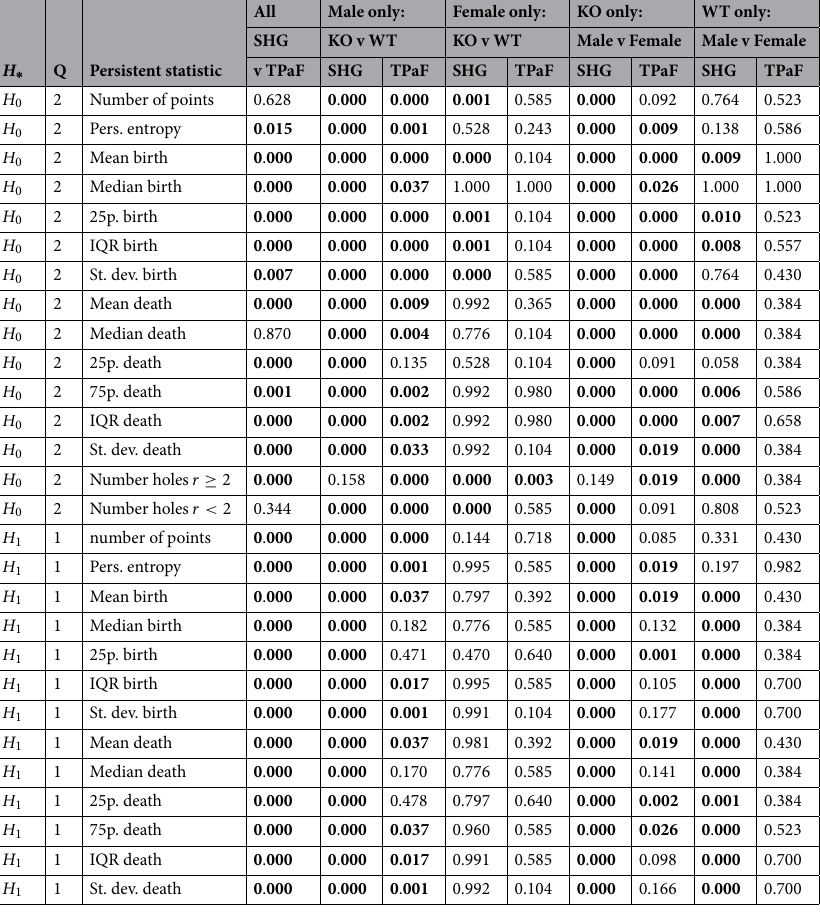
Table 2. Benjamini–Hochberg adjusted pseudo p -values (3 d.p.) from permutation tests for 28 test statistics with paired tests to compare the imaging types and tests between OcnVEGFKO (labelled KO above) and WT males and female groups using either the SHG or TPaF images. To see if there is a significant difference from the imaging technique we paired the TPaF and SHG image patches per statistic. Also, for SHG and TPaF separately we tested the hypothesis that the distributions are the same for males between OcnVEGFKO (test) and WT (WT); females between OcnVEGFKO and WT; OcnVEGFKO between male and female; and WT between male and female. All p -values in bold are significant at the 5% level. The adjustments were made separately for the statistics from TPaF and SHG images in the OcnVEGFKO/WT M/F group comparisons. Here H ∗ is the homology group, Q is the quadrant and we have included statistics from the H 0 quadrant 2 (separate micro-holes) and from H 1 quadrant 1 (loops in bone surrounded by micro-holes). We write p. for percentile, r for radius and st. dev. is the standard deviation. For the interpretation of each persistent statistic, see Table